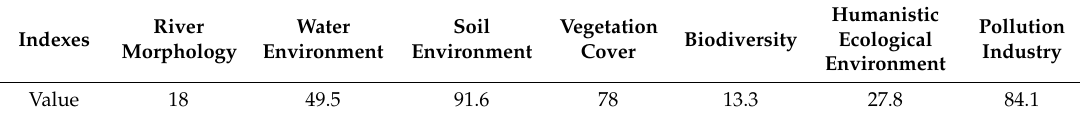
Table 2. Values of environmental impact indexes of Shaheji Reservoir dam break.